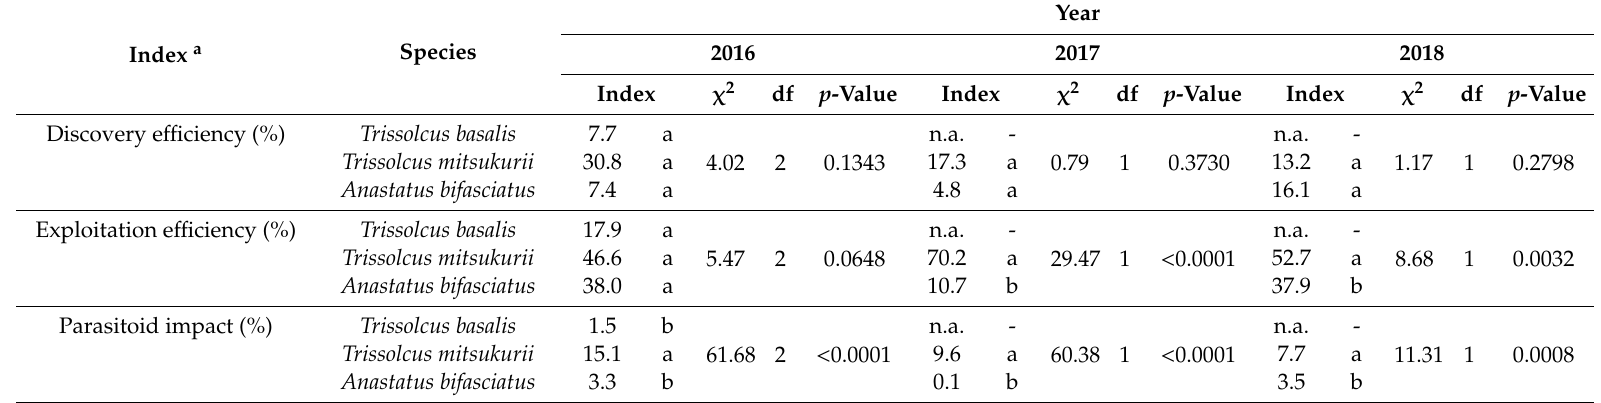
Table 3. Average value of discovery e ffi ciency, exploitation e ffi ciency and parasitoid impact on Halyomorpha halys egg masses, by parasitoid species observed in the three